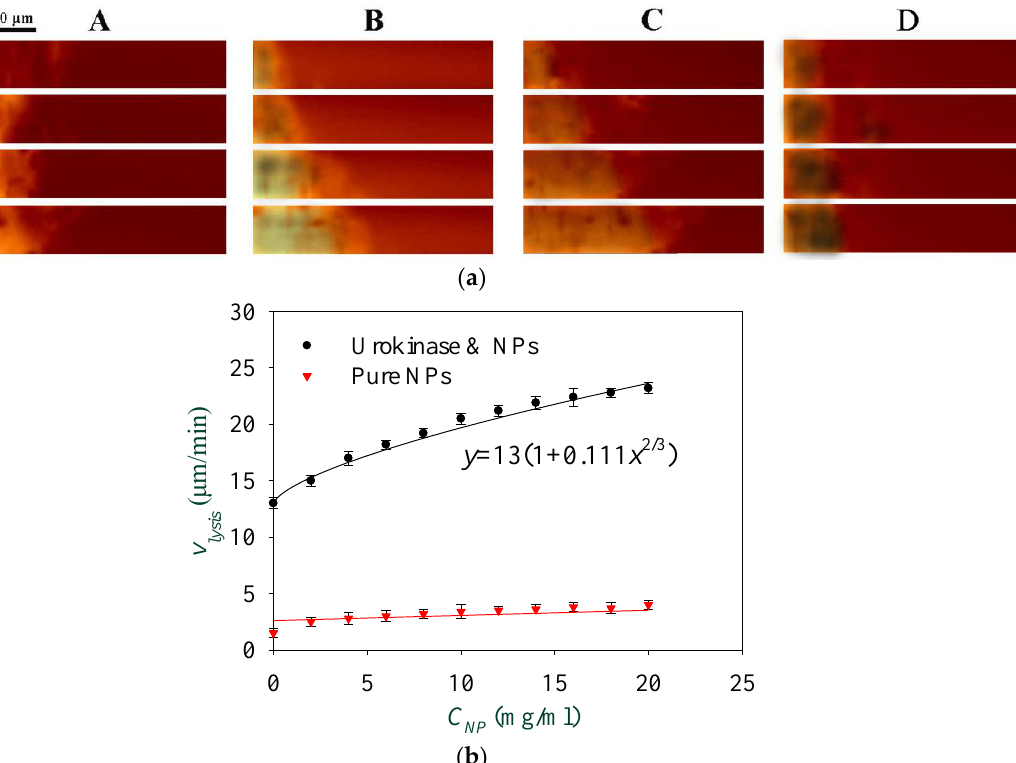
Figure 8. ( a ) Comparison of thrombolytic effects in four microfluidic channels with a urokinase concentration of 30 μg/mL and NPs at concentrations of 0 mg/mL, 5 mg/mL, and 10 mg/mL, and pure NPs (concentration of 5 mg/mL) without urokinase in channels A , B , C , and D , respectively; ( b ) Relationship between the thrombus lysis speed and the nanoparticle concentration with and without urokinase (concentration of 30 μg/mL).